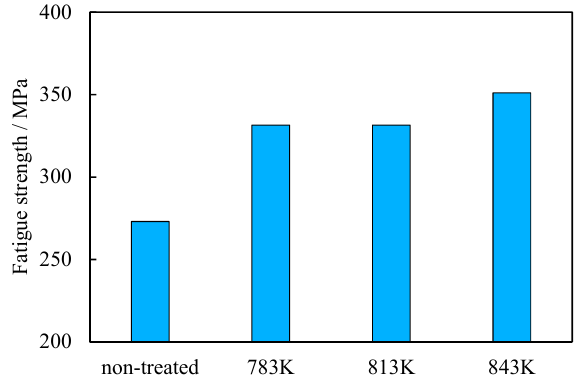
Figure 10. Fatigue strength of ASPN-treated round bar samples.